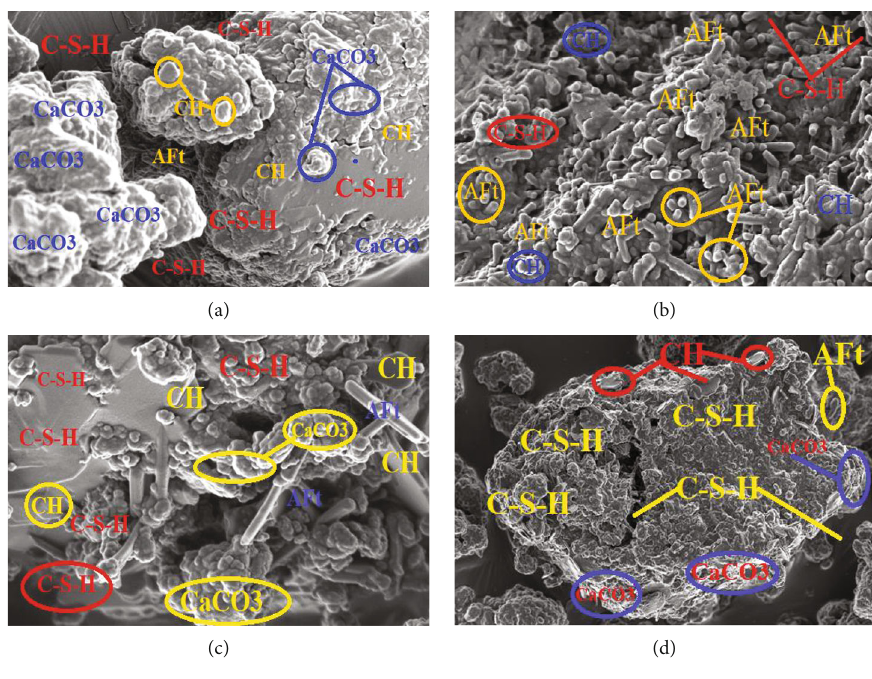
Figure 3: SEM micrographs (a) OPC BE (B-LW), (b) OPC BE (H-A), (c) OPC (B-H), and (d) OPC BE (B-H).